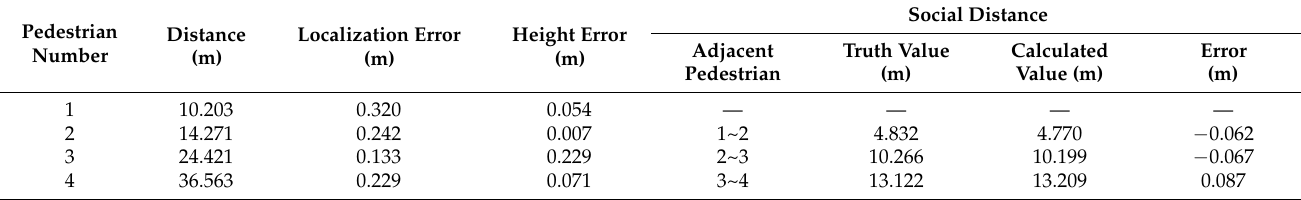
Table 2. Pedestrian localization and height errors of Scene 1 in